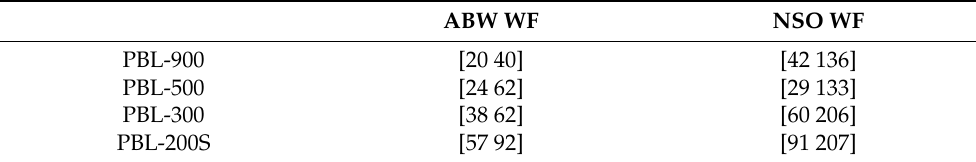
Table 4. Range (min, max) of SCADA 10-min data points for the turbines used in both wind farms (ABW and